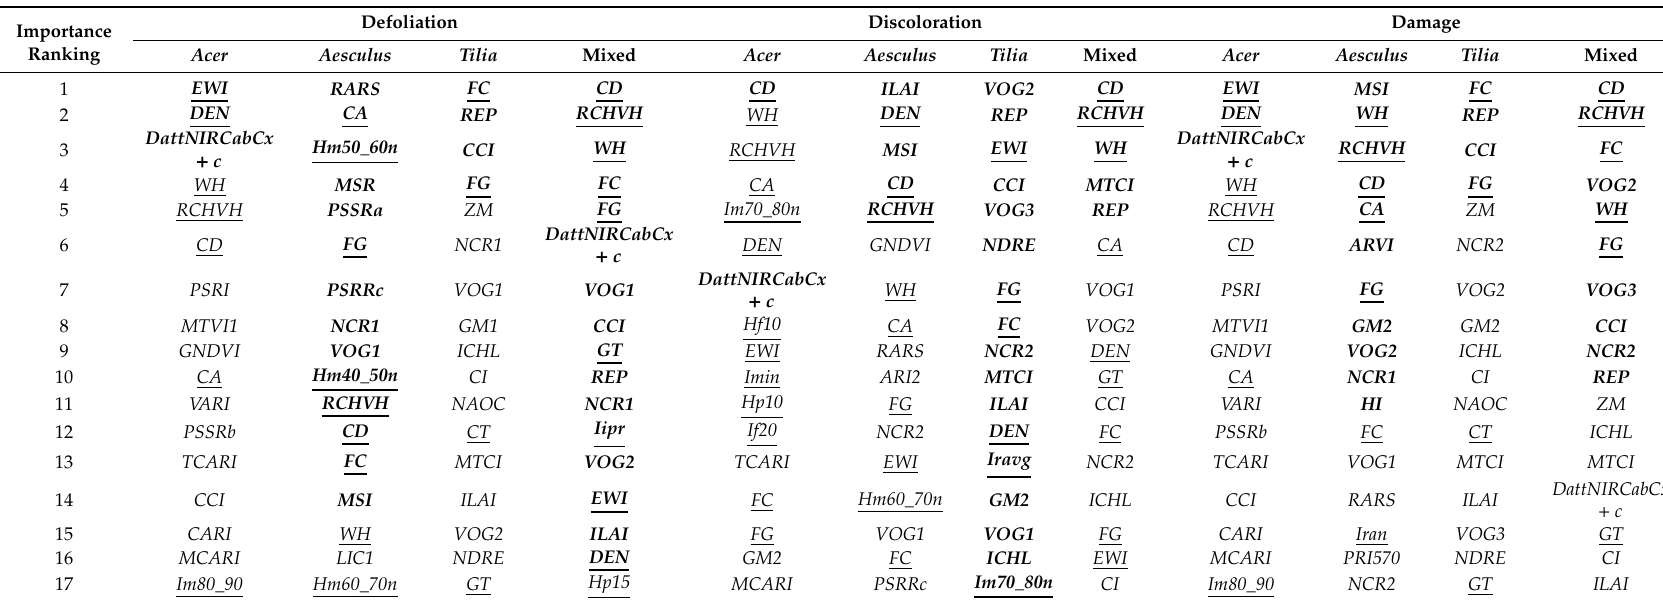
Table 5. The 17 most important indices in ALS-HSI models (scenario 3; Acer , Aesculus and Tilia ) and ALS-HSI mixed models (scenario 4; Mixed) for tree crown defoliation, discoloration and damage (i.e., combination of defoliation and discoloration) classification. ALS indices were underlined to distinguish them from HSI indices. The indices used in the final classification models (according to the forward selection method; cf. Section 2.6.3) are highlighted in bold. The explanation of the index abbreviations can be found in Tables 2 and